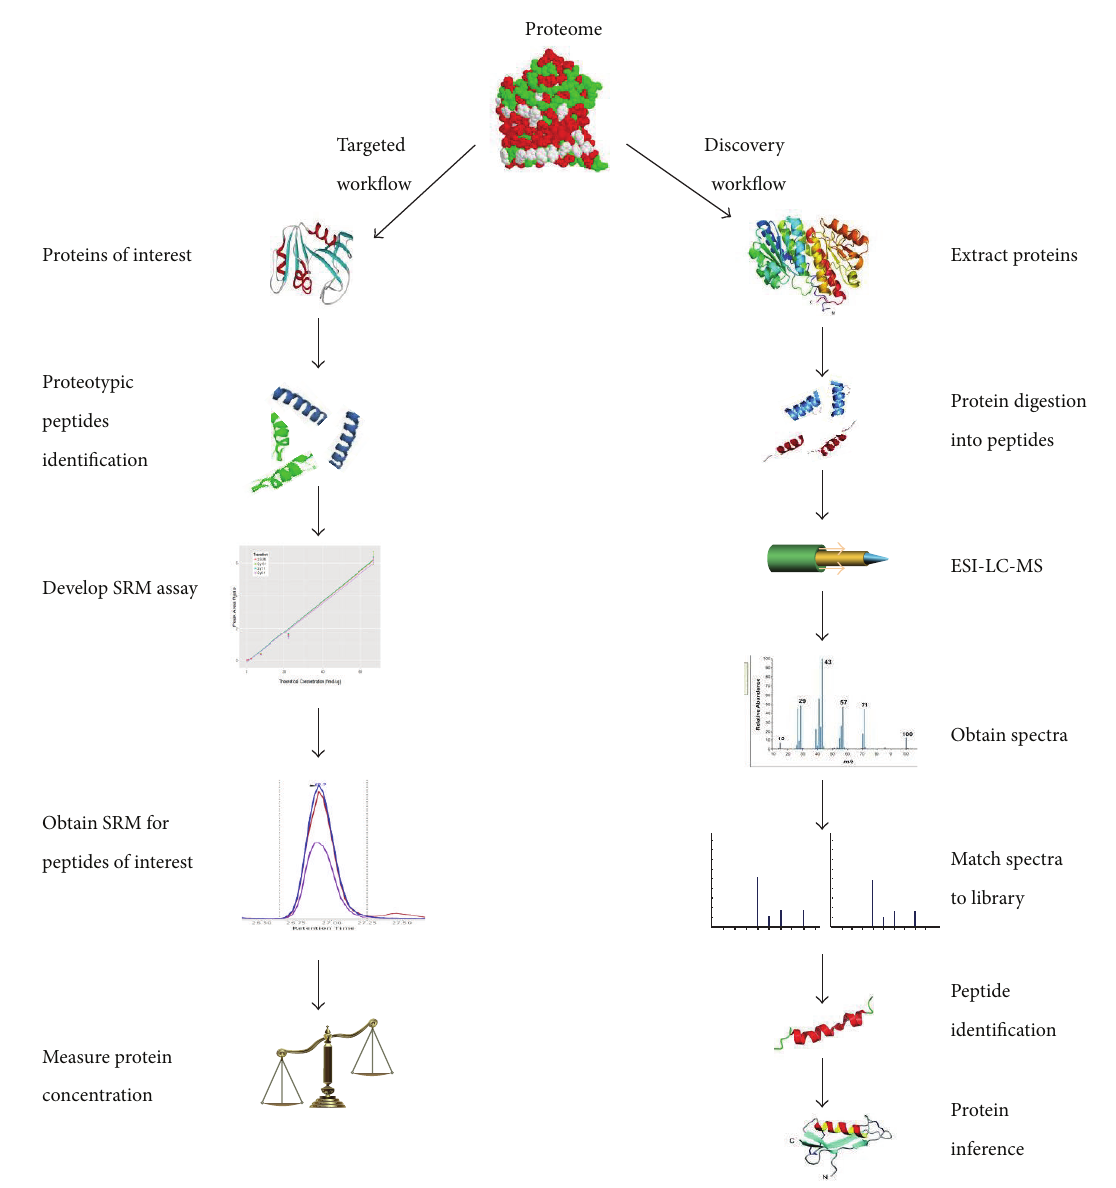
Figure 1: Discovery-based versus targeted proteomics workflows using mass